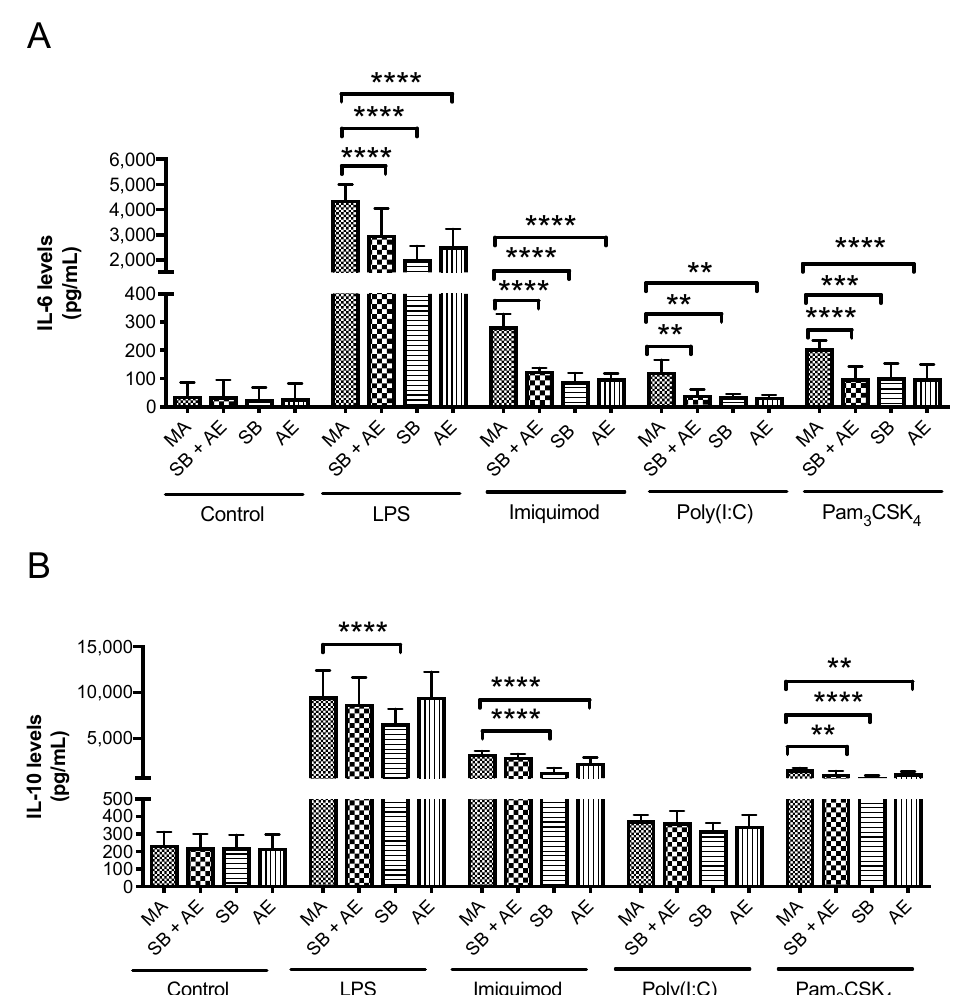
Figure 5. Quantitative determination by ELISA of IL-6 ( A ) and IL-10 ( B ) cytokine levels in supernatants from RAW 264.7 cells cultured over Ti-discs with different surfaces: mechanical abrasion (MA), sandblasting plus etching (SB + AE), sandblasting (SB) and acid etching (AE) and with or without the TLR ligands LPS (TLR4), imiquimod (TLR7), poly(I:C) (TLR3) and Pam3Csk4 (TLR2/1) (n = 3). **, p < 0.0021; ***, p < 0.0002; ****, p < 0.0001.